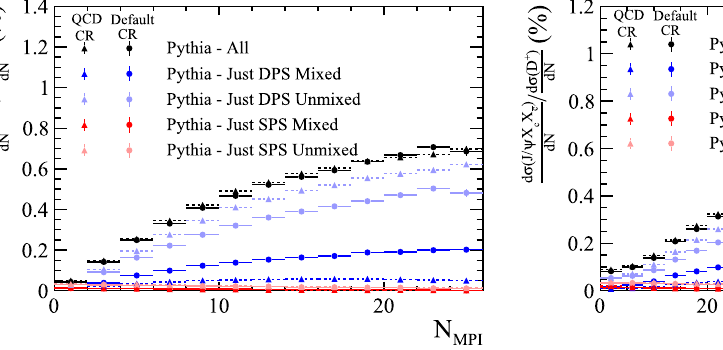
region 2 . 0 < η < 4 . 5, as generated with Pythia both with the alterna- tive CR options specified in Table 4 (triangles) and with the default CR options (circles)